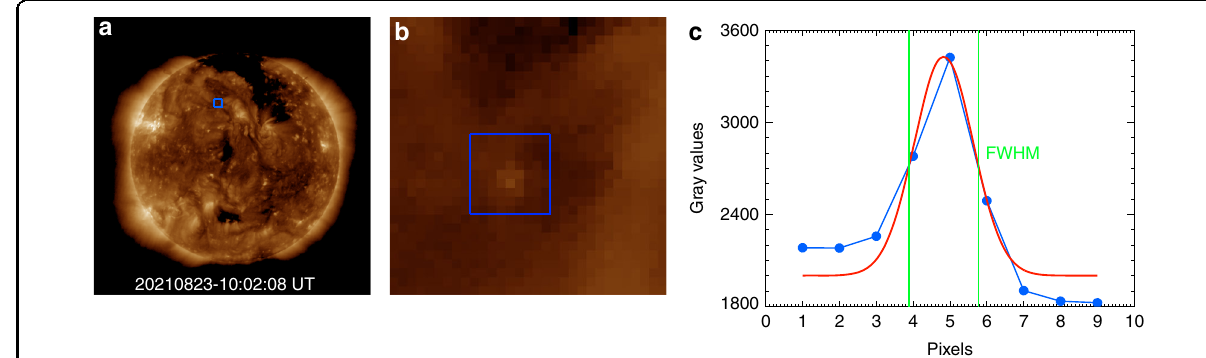
Fig. 6 The observation of a point target to reveal the resolution of X-EUVI. The point target in a is marked in the blue rectangle, b is the enlarged view of the point target, and c is horizontal line across the peak value